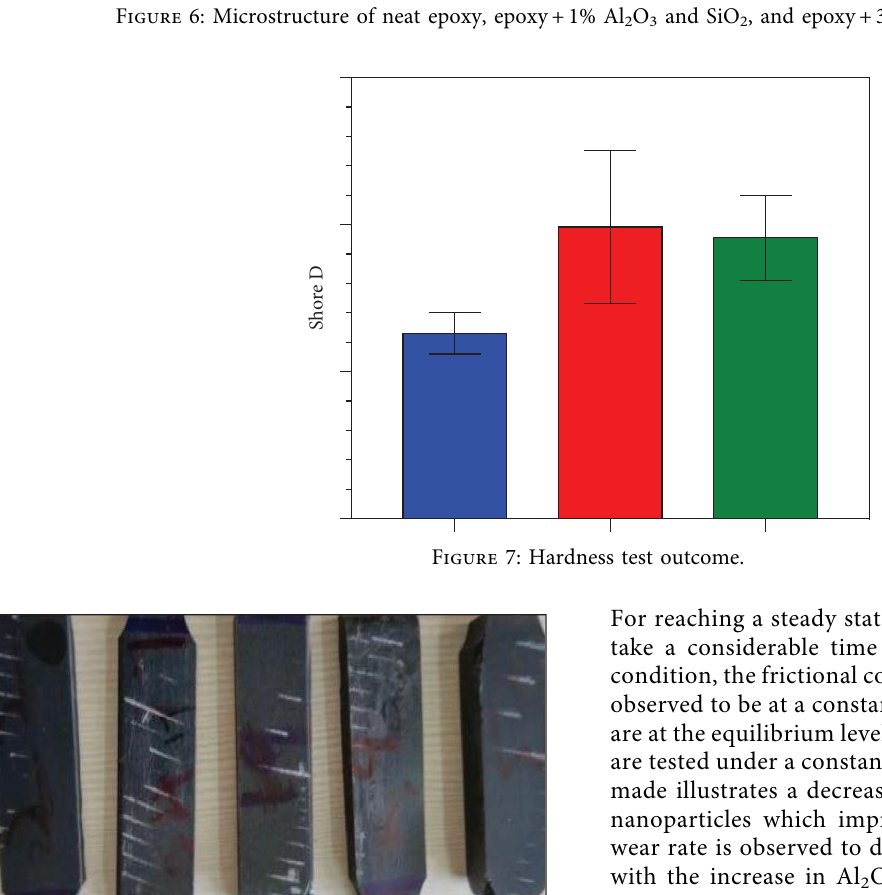
2 O 3 and SiO 2 , and epoxy +3% Al 2 O 3 and SiO 2 .